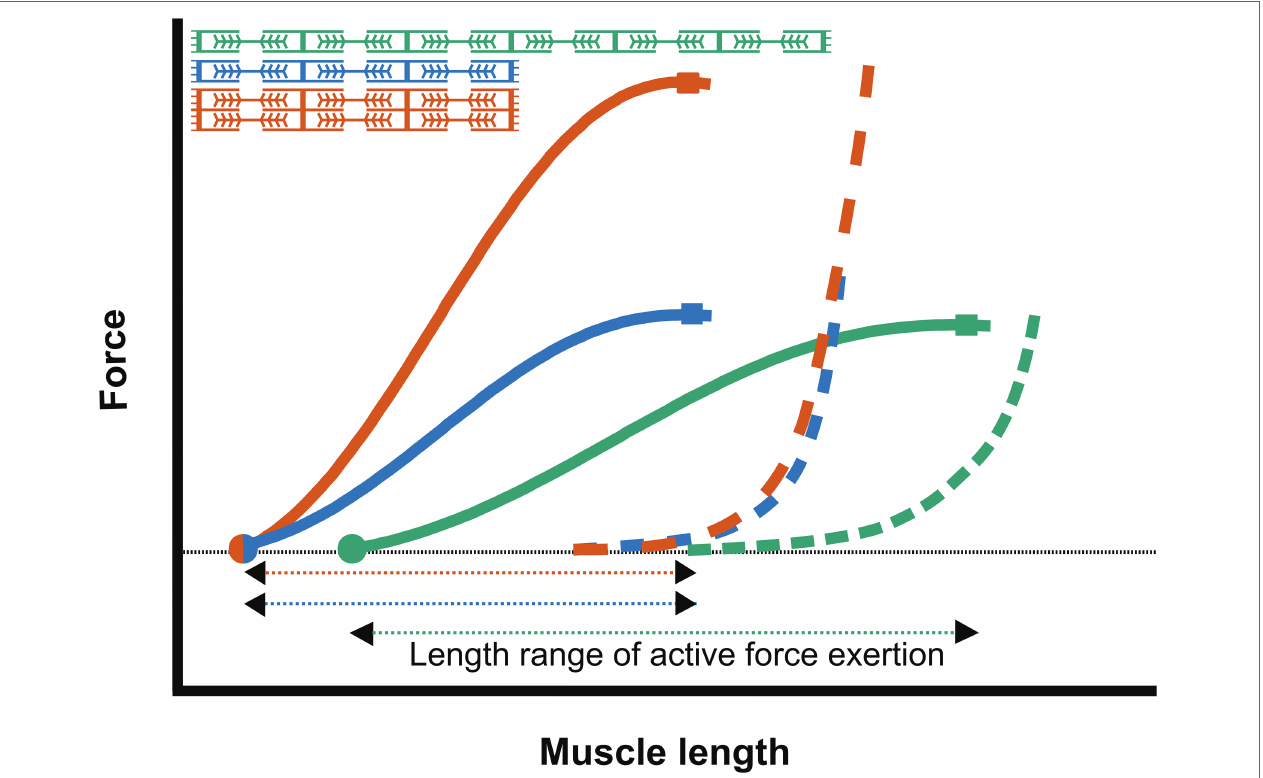
FIGURE 3 | Schematic representation of the length-force relationship of muscles with different sarcomere numbers The active and passive force relationship of a muscle fiber with a low number of parallel and serial sarcomeres (blue); a muscle fiber with double number of parallel sarcomeres (red); and a muscle fiber with double number of serial sarcomeres (green). Increasing the number of sarcomeres in series results in increased active slack (dots) and optimum length (squares), as well as an increase in the length range of active force exertion. Increasing the number of parallel sarcomeres results in a higher optimal muscle force, without increasing the active slack and optimum muscle length or the length range of active force